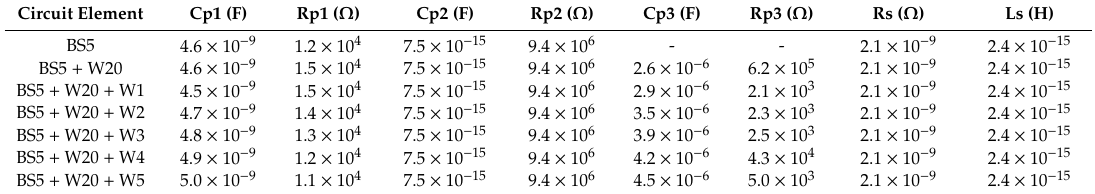
Table A1. Modeled impedance parameters Cp1, Rp1, Cp2, Rp2, Cp3, Rp3, Rs, and Ls of biochip BS5, with DI water.